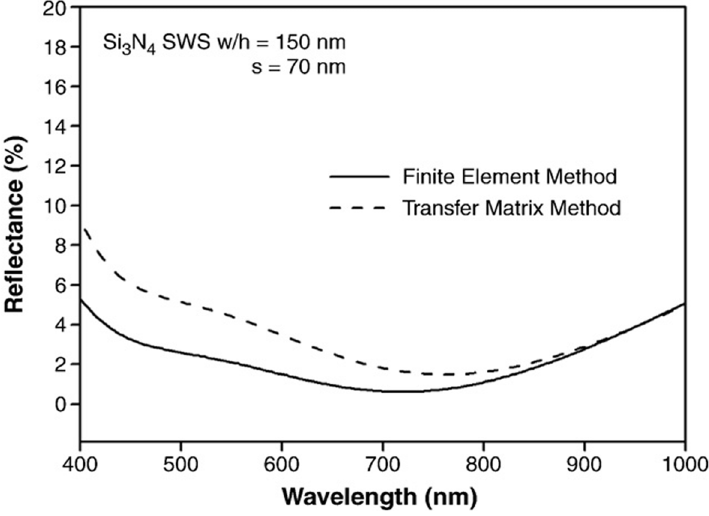
Figure 28. Comparison of reflectance calculations from FEM and TMM. Reprinted with permission from reference [125], Copyright 2010